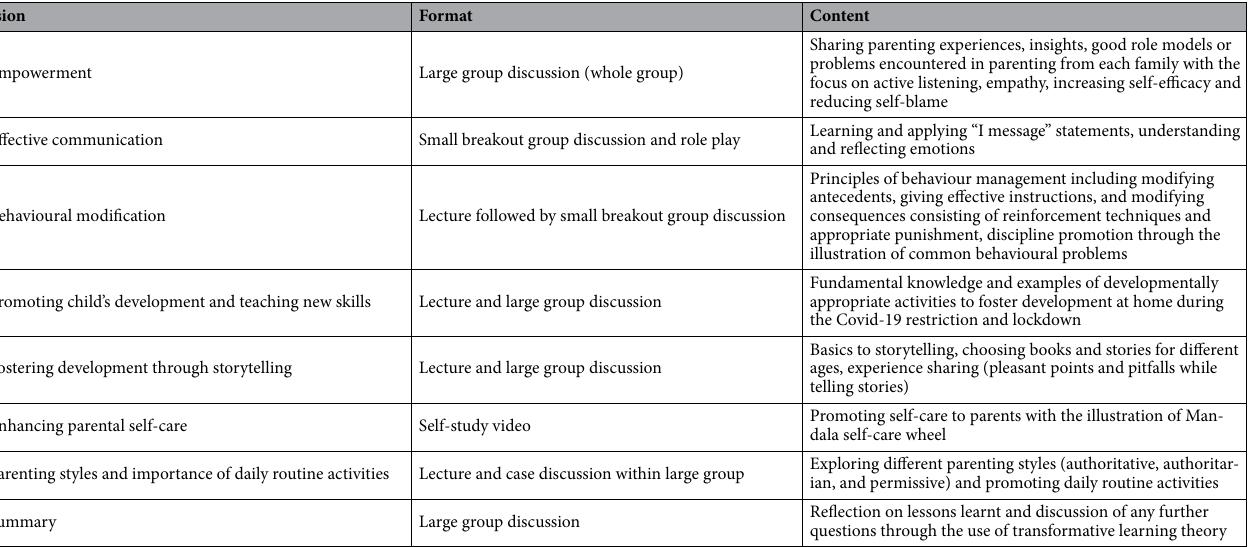
Table 1. Development process and details of online positive parenting programme. Step 1. Literature review and identification of salutogenic factors affecting parenting. Step 2. Selection of key contents for positive parenting training from clinical standpoints. Step 3. Multidisciplinary team expert consensus on contents and formats of each session. Step 4. Layout of session details including format and